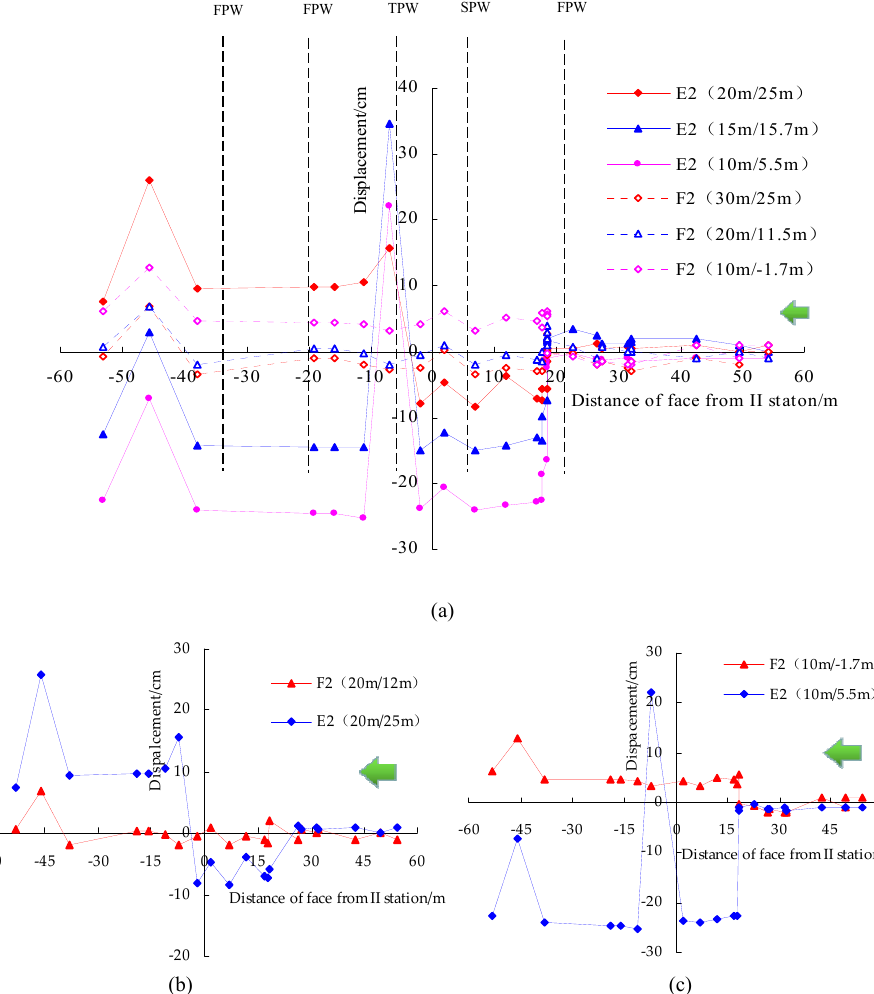
Figure 19. Displacement of the E and F drillholes at the II station: (a) displacement of the E and F drillholes; (b) displacement of the E2(20m/12m) and E2(20m/25m); (c) displacement of the E2(10m/ 5.5m) and F2(10m/-1.7m). Based on the above analysis, the height of the overburden caving zone is about 15~18 m. Through the surface observation, the sinking funnel appears on the surface when the first weighting is applied, and the periodic step crack height reaches 1.7m, indicating that the roof of the large mining height in typical shallow buried forms the “step rock beam” [1], and the surface is discontinuously deformed. Field the surface formed step cracks, as shown in Figure 20.